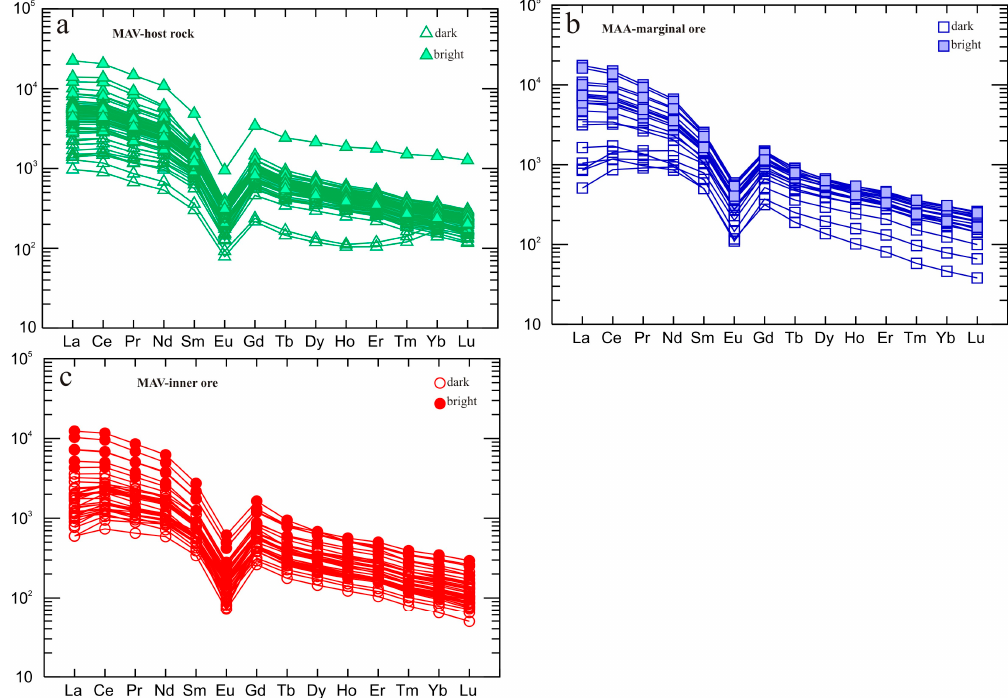
Figure 14. Chondrite-normalized REE patterns for dark and bright areas in the three different apatite types. ( a ) AMV-host rock; ( b ) MAA-marginal ore; ( c ) MAV-inner ore. Chondrite values after [56].